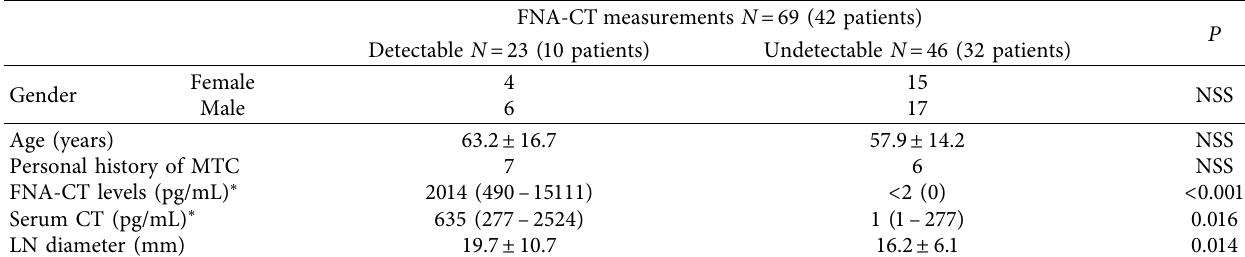
Table 1: Patients characteristics according to FNA-CT measurement.